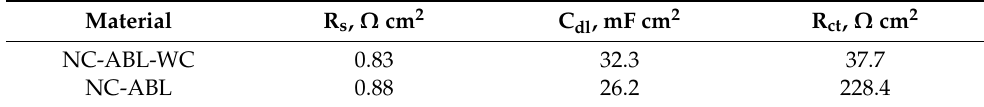
Table 2. Parameters of EIS for NC-ABL-WC and NC-ABL carbon